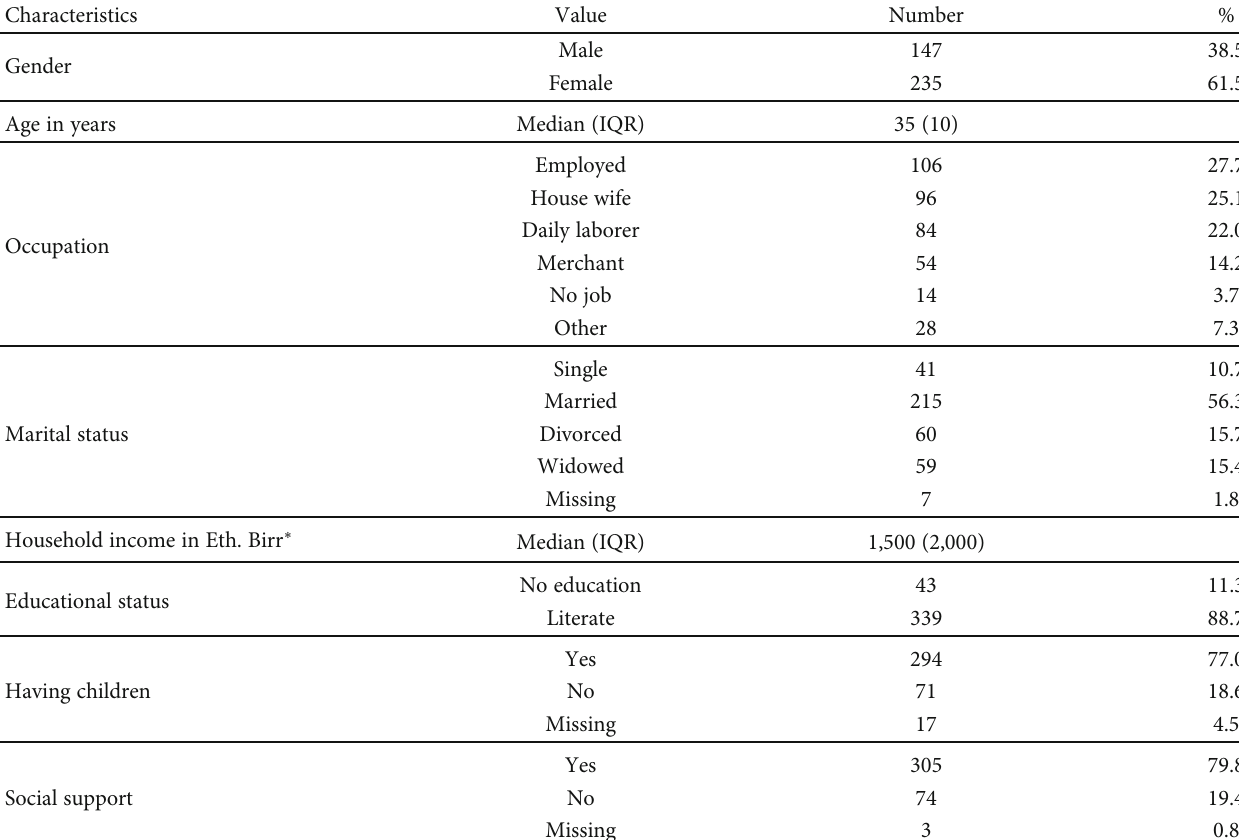
Table 1: Sociodemographic characteristics of people living with HIV at HUCSH, April